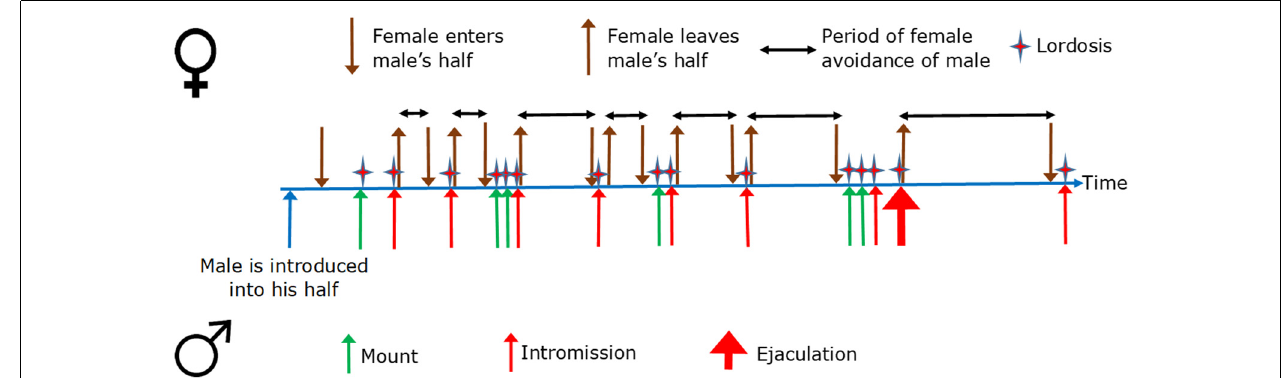
FIGURE 3 | Sexual behavior in a cage in which the female can escape from the male copulation partner. The female is present already at the beginning of the timeline. The horizontal, double-ended black arrows represent the time the female has escaped from the male into her own half. The illustration ends after the first intromission following the first ejaculation. Copulation may have continued for several ejaculations, however.